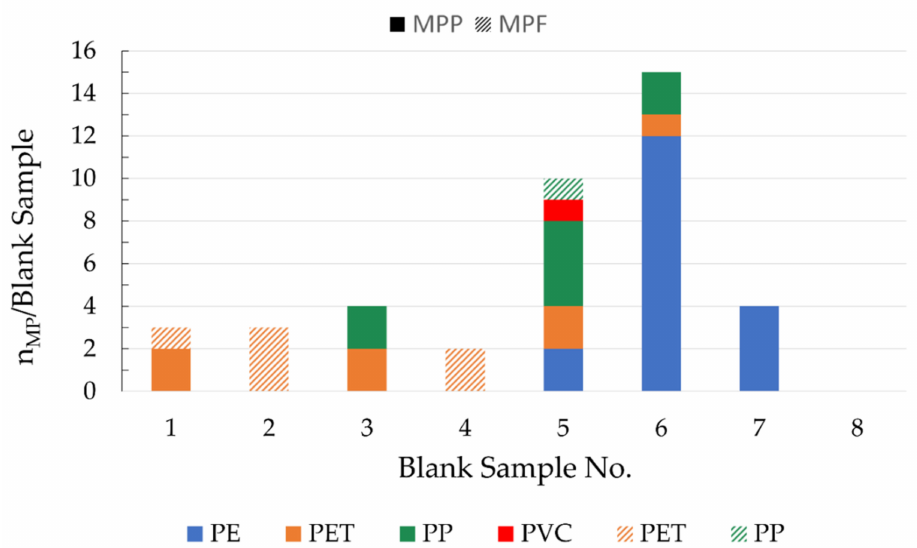
Figure 9. Identified MPP and MPF in blank samples 1–8 (not